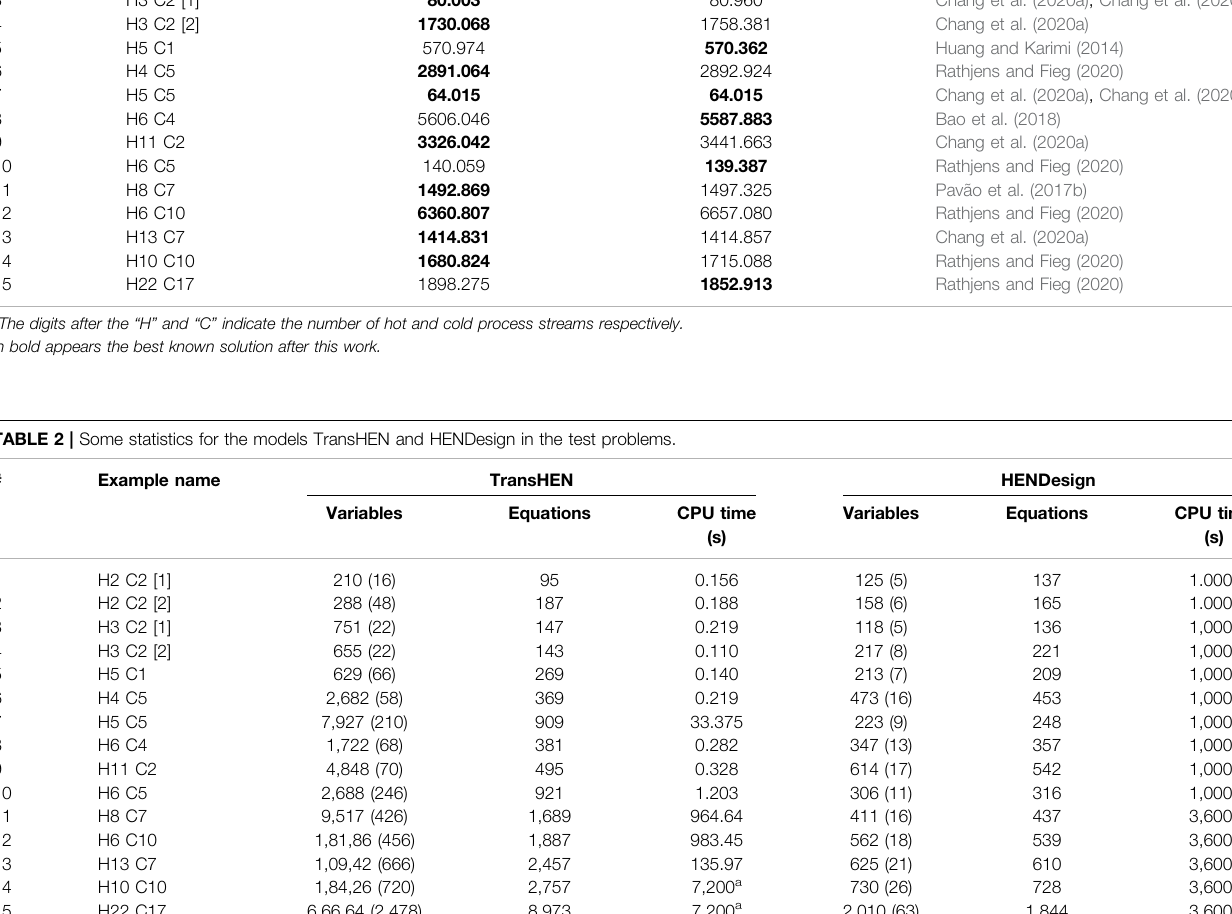
TABLE 1 | Summary of the main results of the examples and comparison with the best-known solution.